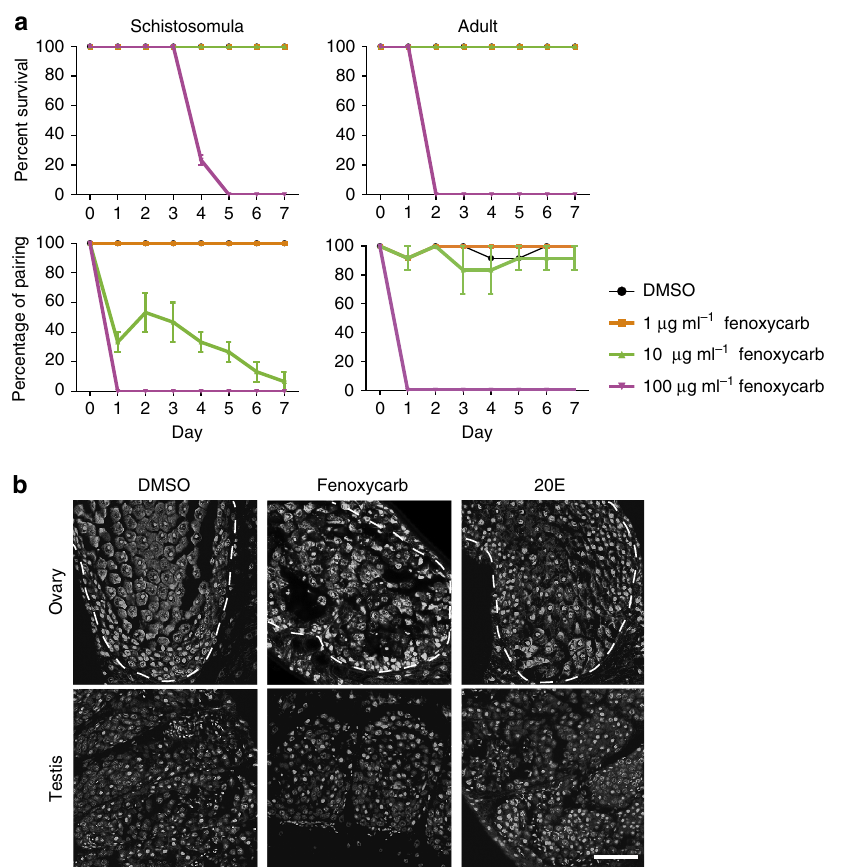
Figure 6 | Effects of insect hormones on the physical activity and reproduction of S. japonicum. ( a ) Effects of fenoxycarb, an analogue of JH, on the survival and pairing activities of S. japonicum (mean ± s.e.m., n ¼ 3). ( b ) Confocal laser scanning micrographs documenting morphological changes in the reproductive organs and anatomy of adult S. japonicum cultured in 1 m gml (cid:2) 1 fenoxycarb or 20E. n 4 5 parasites per experiment. Dotted line indicates ovary. Scale bar, 50 m